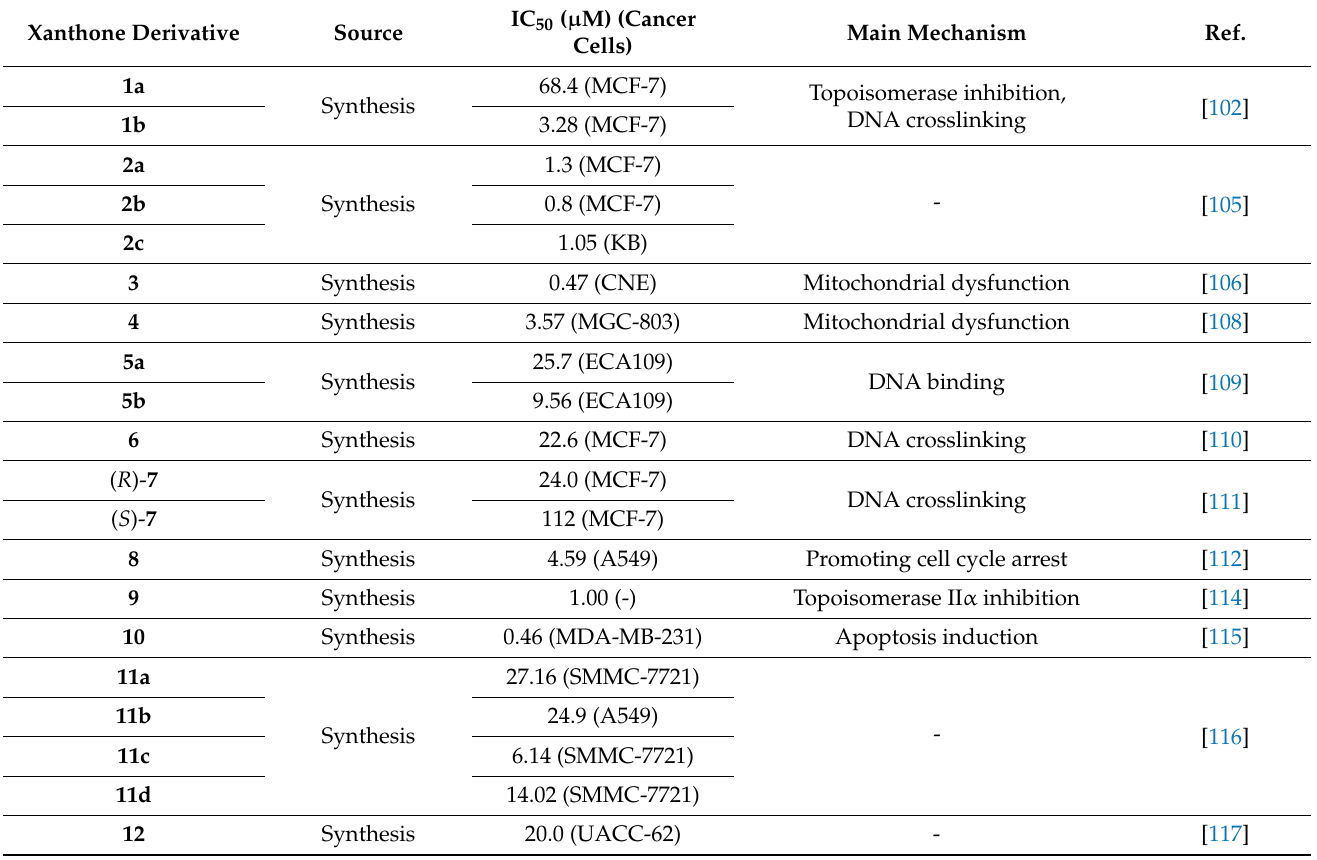
Table 3. Summary of the in vitro anticancer activity assay of reported xanthone